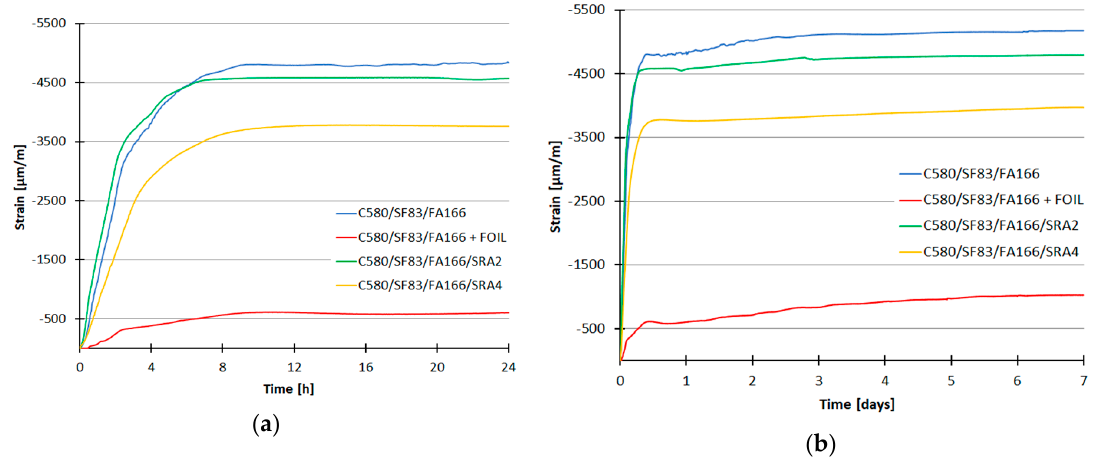
Scheme 7. Average deformation over time: ( a ) 24 h; ( b ) 7